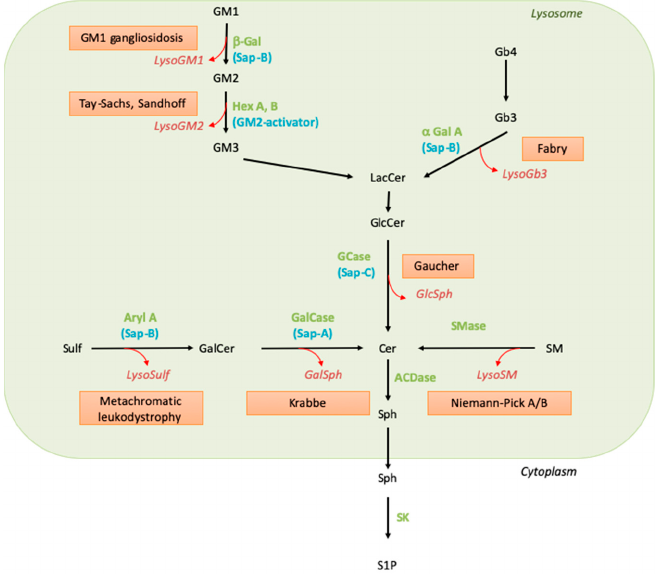
Figure 1. Sphingolipid catabolism and associated diseases. Green names correspond to the enzyme names, blue names to their activators, the red boxed texts contain the disease name, and the red and italic names indicate the corresponding lysoSL. Abbreviations: α -Gal: alpha-galactosidase; AC- Dase, acid ceramidase; Aryl A, arylsulfatase A; β -Gal, beta-galactosidase; Cer, ceramide; GalCase, galactosylceramidase; GalSph, galactosylsphingosine; GCase, glucosylceramidase; GlcCer, glucosyl- ceramide; GlcSph, glucosylsphingosine; Hex, hexosaminidase; LacCer, lactosylceramide; LysoSulf, lysosulfatide; Sap, saposin; SK, sphingosine kinase; SM, sphingomyelin; SMase, sphingomyelinase; Sph, sphingosine; Sulf, sulfatide; S1P, sphingosine